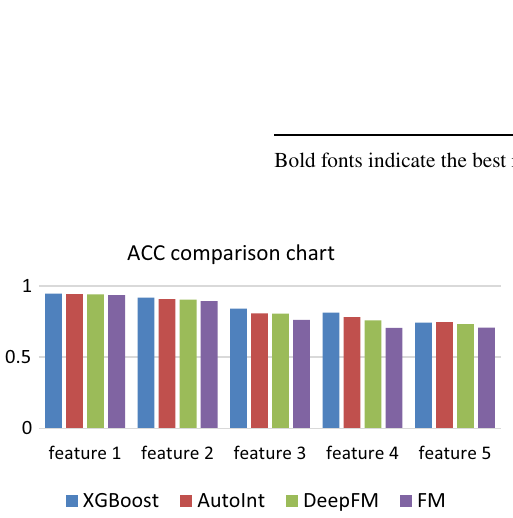
Fig. 2 ACC for XGBoost, AutoInt, DeepFM, and FM model